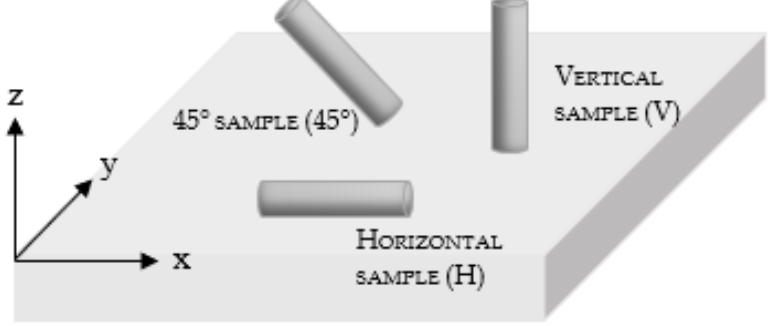
Figure 8. Schematics of commonly projected building directions for tensile specimens.